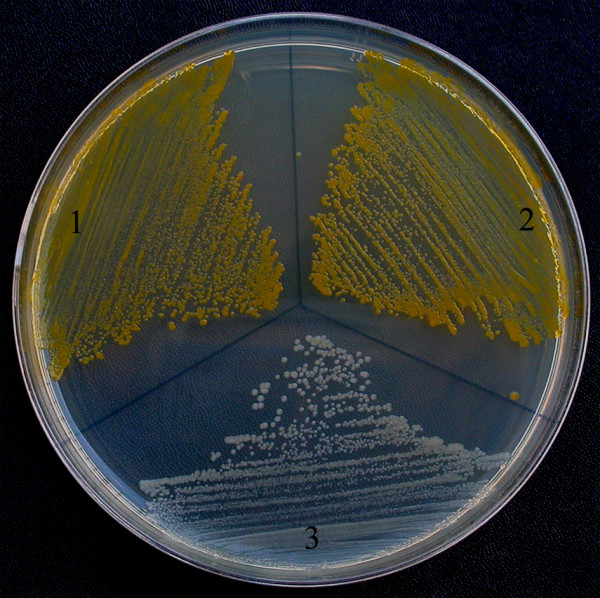
Carotenoid production of E. coli harboring plasmid pACCAR25ΔcrtE and plasmid expressing. (1) mouse GGPP synthase, pBAA; (2) plasmid expressing C. forskohlii GGPP synthase, pGGPPS; and (3) pBluescript II KS- vector, pBS